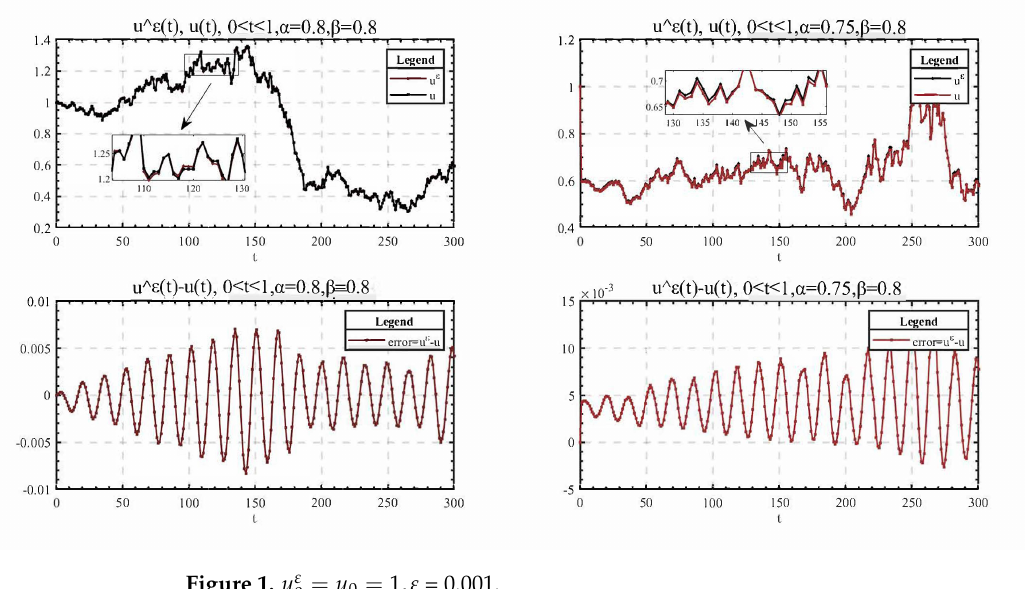
= u = 1, ε = 0.001. 0 0